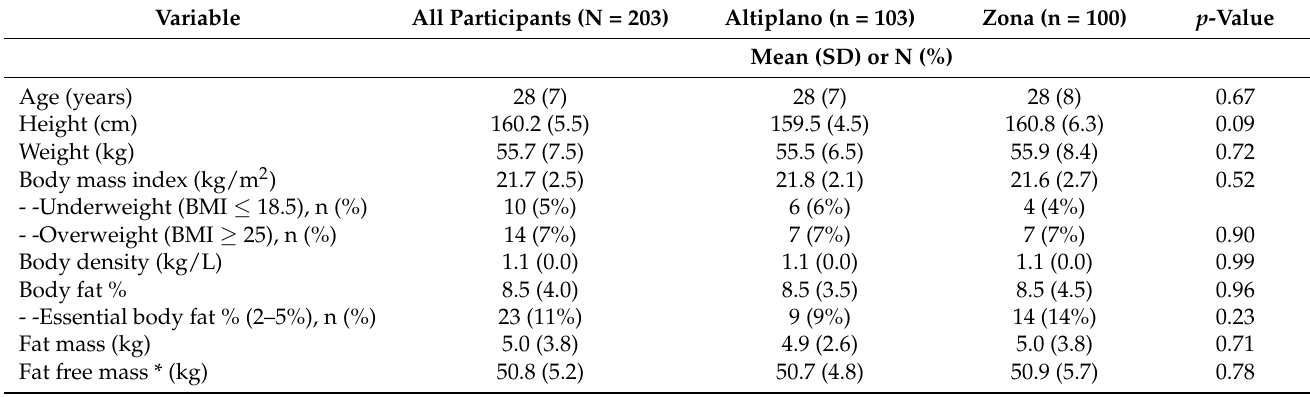
Table 1. Univariate comparisons of demographic and anthropometric measures between workers from highland communi- ties (Altiplano) versus coastal (Zona), mid-harvest, January